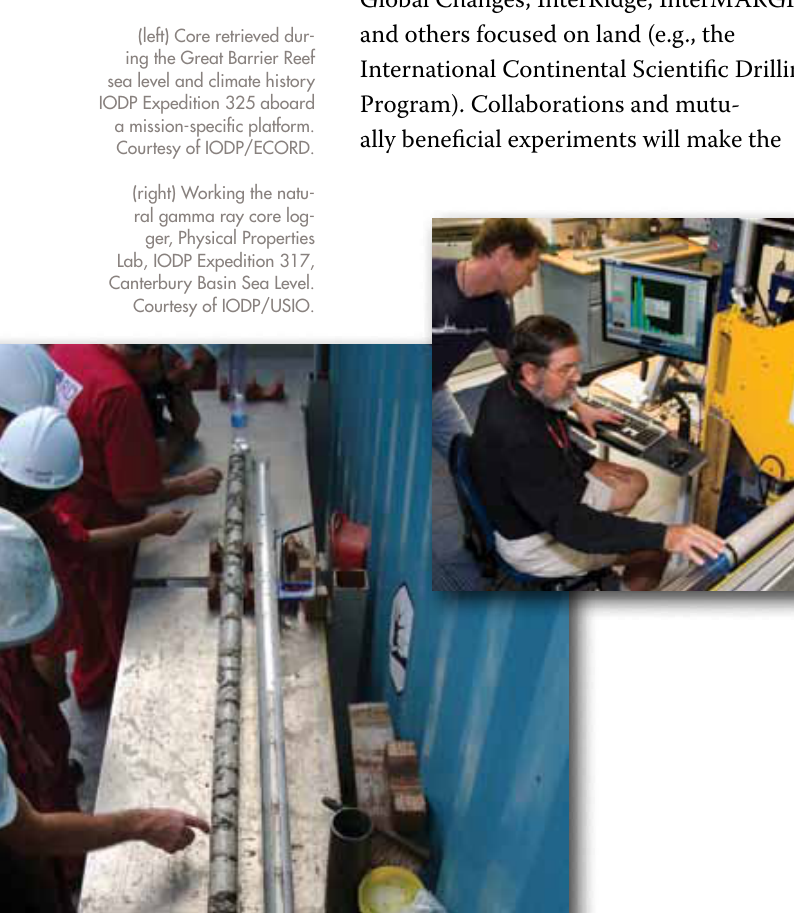
(left) core retrieved dur- ing the great Barrier reef sea level and climate history iodp expedition 325 aboard a mission-specific platform. courtesy of iodp/ecord. (right) Working the natu- ral gamma ray core log- ger, physical properties lab, iodp expedition 317, canterbury Basin sea level. courtesy of